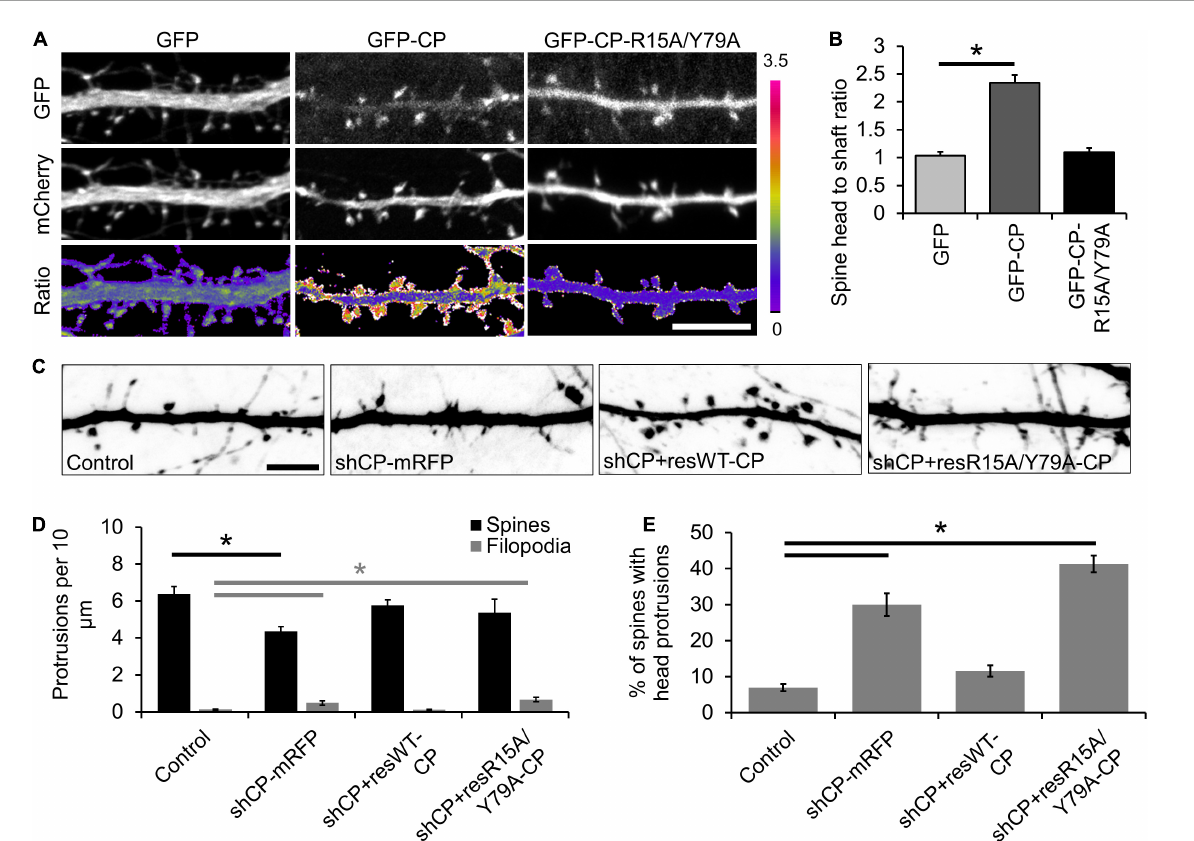
FIGURE2 Capping protein interaction (CPI)-motif proteins regulate capping protein (CP) localization and spine morphology. (A) Representative images of DIV21 neurons co-expressing mCherry (volume marker) with either green fluorescent protein (GFP), GFP-CP, or GFP-CP-R15A/Y79A. Bottom row, GFP/mCherry ratiometric images. Scale bar, 5 µ m. (B) CP enrichment in spines requires interactions with CPI-motif proteins. Quantification of spine enrichment, expressed as the ratio of GFP fluorescence intensity in a spine head to the intensity of an equal-size area in the neighboring dendritic shaft. N = 18 neurons (12 protrusions/cell). Error bars represent SEM. * P < 0.0001; one-way ANOVA with Tukey’s post hoc test. (C) CPI-motif interactions are necessary to rescue spine defects in CP knockdown neurons. Representative images of dendritic protrusions from neurons expressing pSuper-mCherry (control), shCP-mRFP, shCP + resWT-CP, and shCP + resR15A/Y79A-CP. Scale bar, 5 µ m. (D) Quantitative analysis of filopodia and spine density. (E) Analysis of the percentage of spines containing spine head protrusions. Error bars represent SEM. * P < 0.01; one-way ANOVA with Tukey’s post hoc